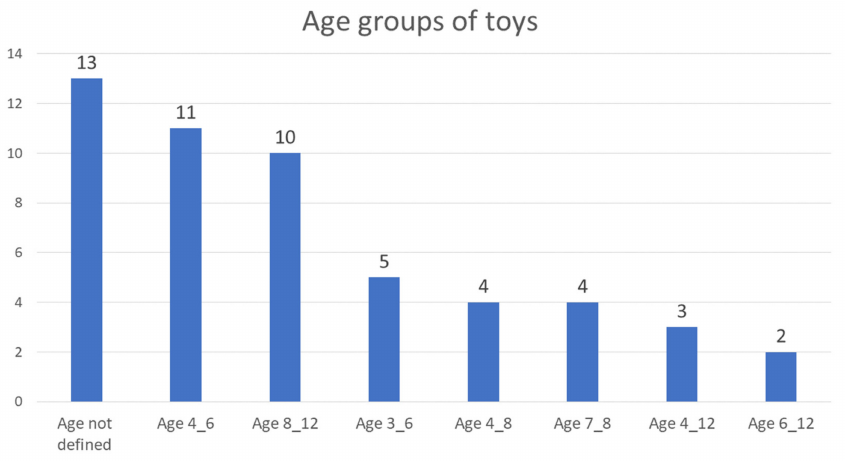
Figure 3. Age groups of toys.